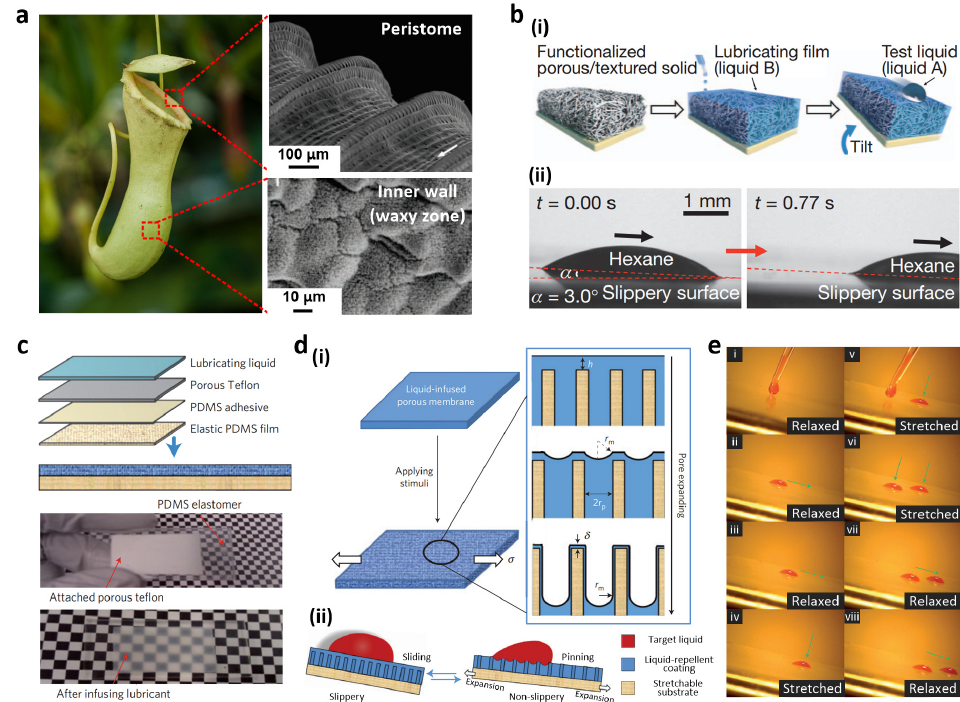
Figure 6. ( a ) Image of the Nepenthes pitcher plant (image by William Warby, reproduced under CC BY) and SEM images of the peristome surface and inner wall. The surface presents radial ridges, while the inner wall is covered with waxy crystals; ( b ) ( i ) Slippery film fabrication; ( ii ) Optical micrographs of a sliding hexane drop at a low angle; ( c ) Porous matrix formation on an elastic PDMS film and photographs of dry and lubricated substrates; ( d ) ( i ) Mechanically induced topographical changes in a liquid slippery film upon stretching and ( ii ) corresponding droplet motions; ( e ) Sequential photographs of oil droplet movement on the dynamic slippery surface. Reproduced from [13,93,94] with permission by National Academy of Sciences of the USA, Copyright 2004 and by Nature Publishing Group, Copyright 2011, 2013.